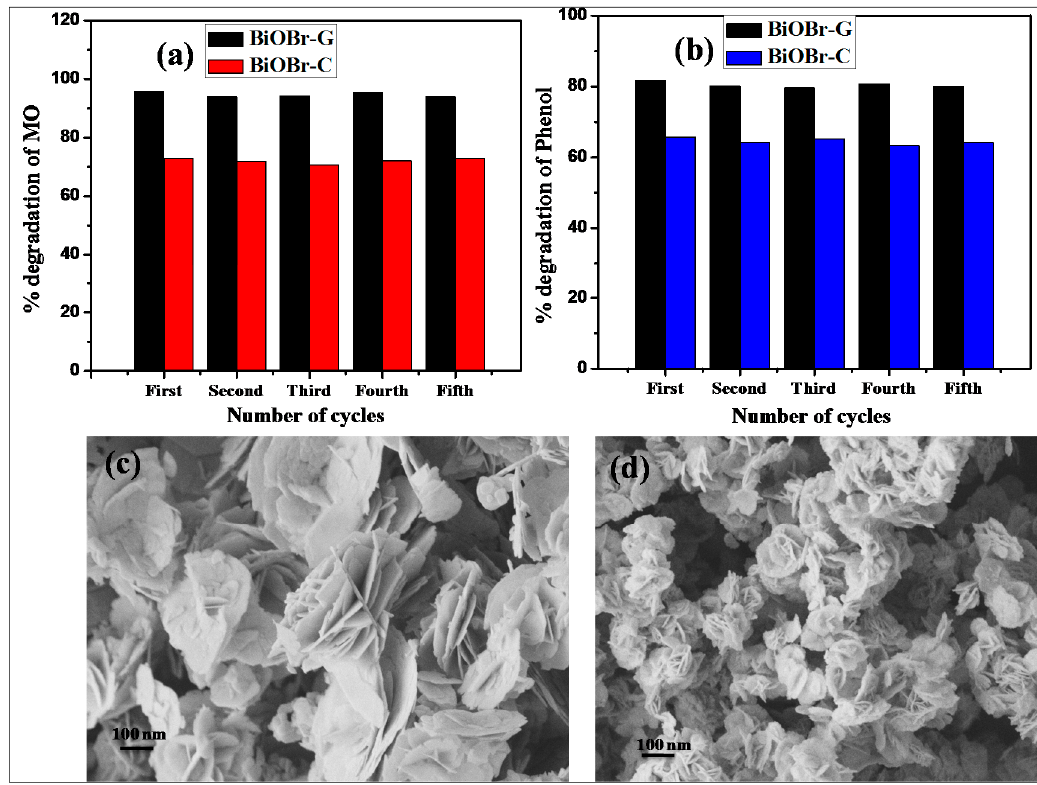
Figure 8. Recyclability of BiOBr ‐ C and BiOBr ‐ G for ( a ) MO and ( b ) Ph; FESEM images after five cycles ( c ) BiOBr ‐ C, and ( d ) BiOBr ‐ G.